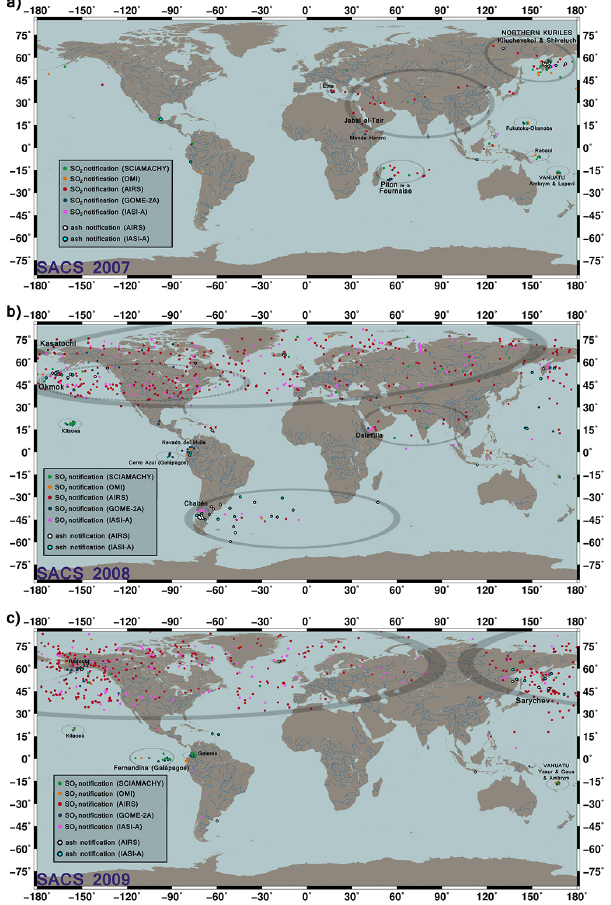
Fig. 15. SACS notifications for 2007, 2008 and 2009.